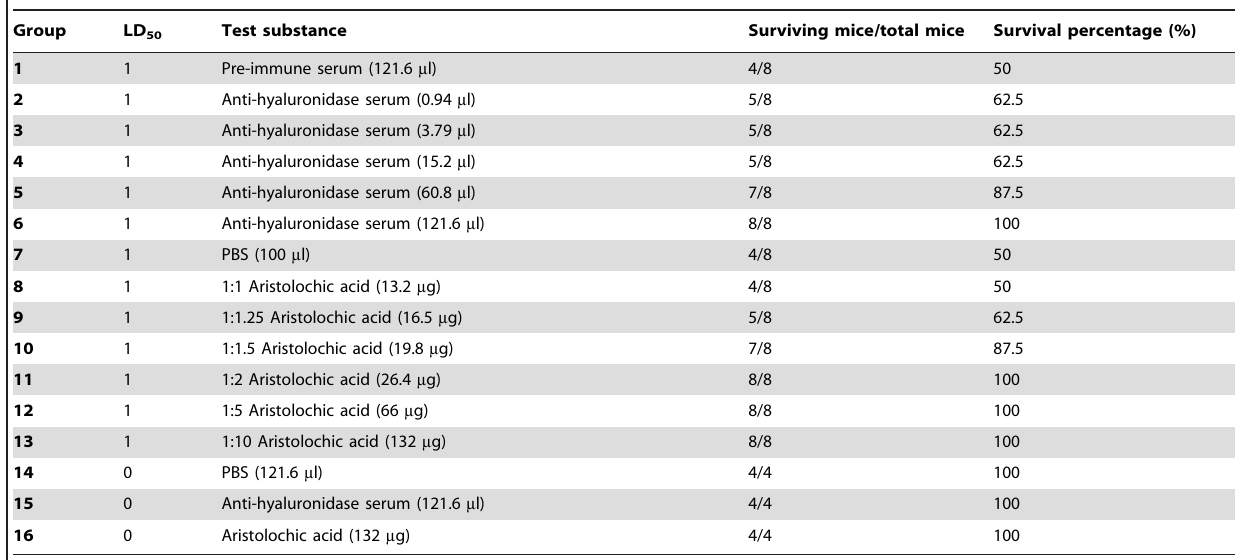
Table 1. In vivo protection